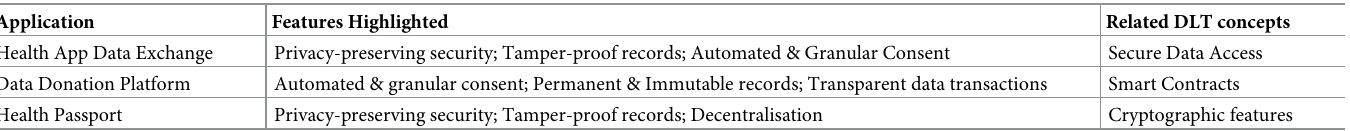
Table 1. CDIP public engagement scenarios